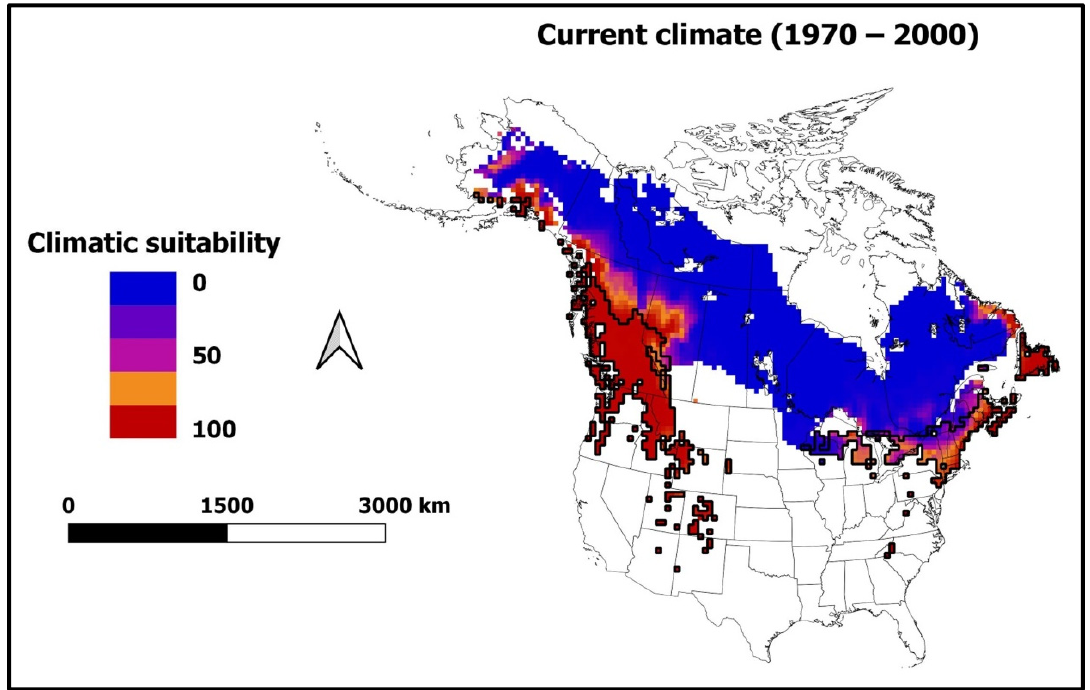
Figure 6. Climatic suitability of spruce forests in Canada and the United States for Ips typographus during the current period (1970–2000). Thick black line overlapping the I. typographus map represents climatically suitable area for Endoconidiophora polonica .